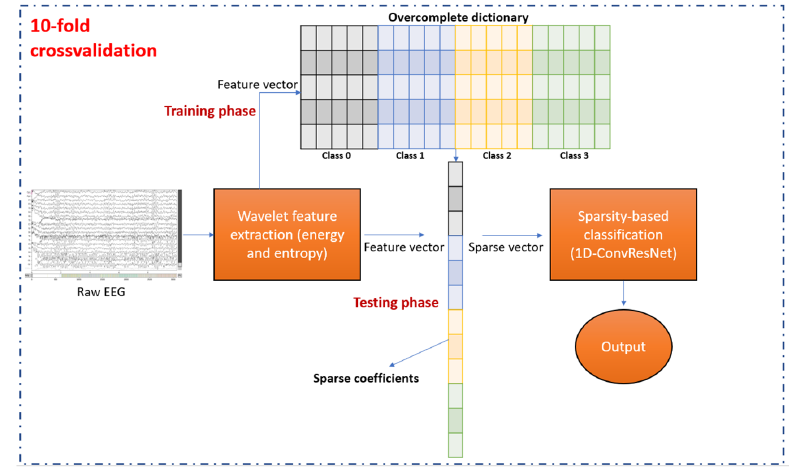
Figure 2. Overview of the methodology used in the present work.